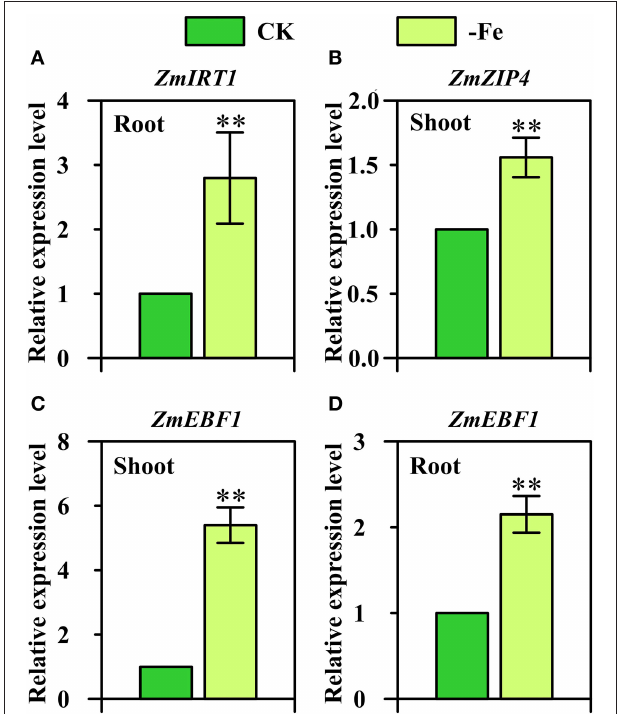
FIGURE 7 | Relative expression levels of strategy I genes (A) ZmIRT1 (GRMZM2G118821), (B) ZmZIP4 (GRMZM2G111300), and (C,D) ZmEBF1 (GRMZM2G171616) in the shoots (B,C) and/or roots (A,D) of Ye478 grown under Fe-deficient (-Fe) and Fe-sufficient (CK) conditions. ** Indicates significant differences between treatments at P <